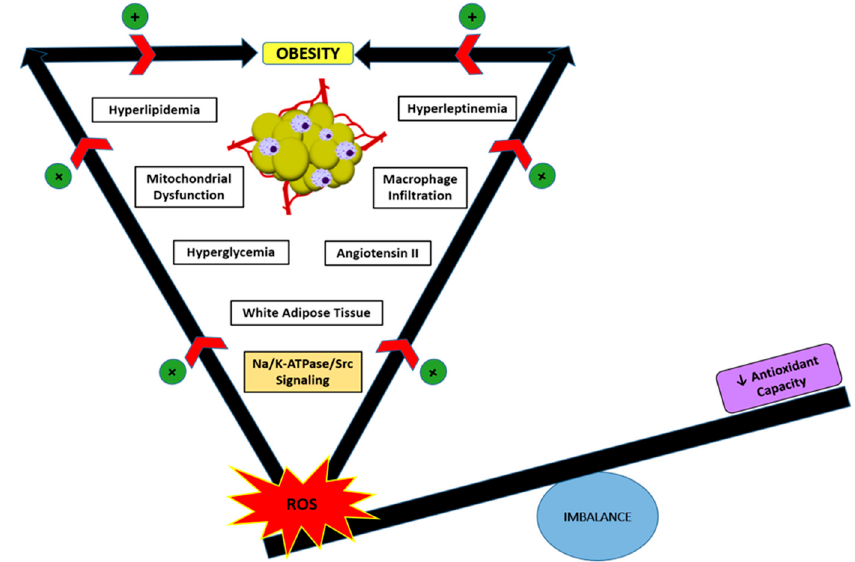
Figure 3. Systemic imbalance of prooxidants vs. antioxidants in obesity. Sources of ROS in the obese state, including the Na/K-ATPase/Src signaling pathway, engage in a positive feedback loop to produce more ROS, in a setting of limited antioxidant capacity, thereby worsening the existing obesity and comorbid conditions.